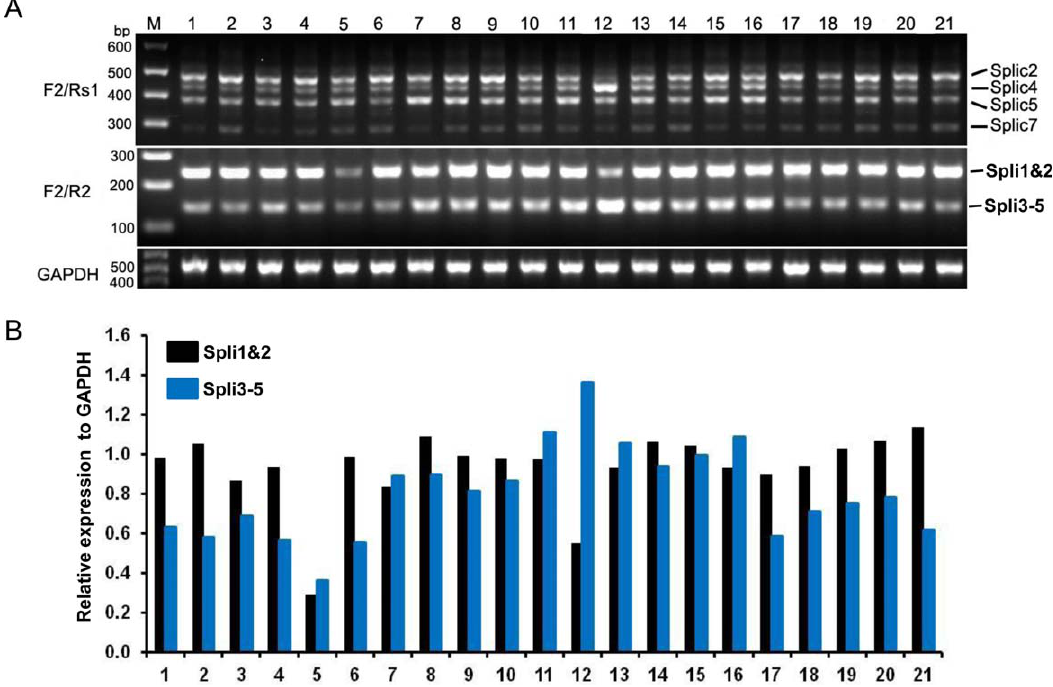
Figure 3. mRNA expression profile of FBXW7 a AS forms in human normal tissues. (A) FBXW7 a AS forms expression levels were detected by semi-quantitative RT-PCR using different pairs of primers. (B) The levels of Spli1&2 and Spli3-5 expression were quantified from the experiment shown in (A) lower panel. Normal tissues include: 1-esophagus, 2-adipose, 3-heart, 4-bladder, 5-kidney, 6-brain, 7-liver, 8-lung, 9-cervix, 10-colon, 11-spleen, 12-testes, 13-thymus, 14-thyraoid, 15-trachea, 16-small intestine, 17-skeletal muscle, 18-prostate, 19-placental, 20-ovary, 21-breast. ‘‘M’’ represents DNAs ladder Marker.